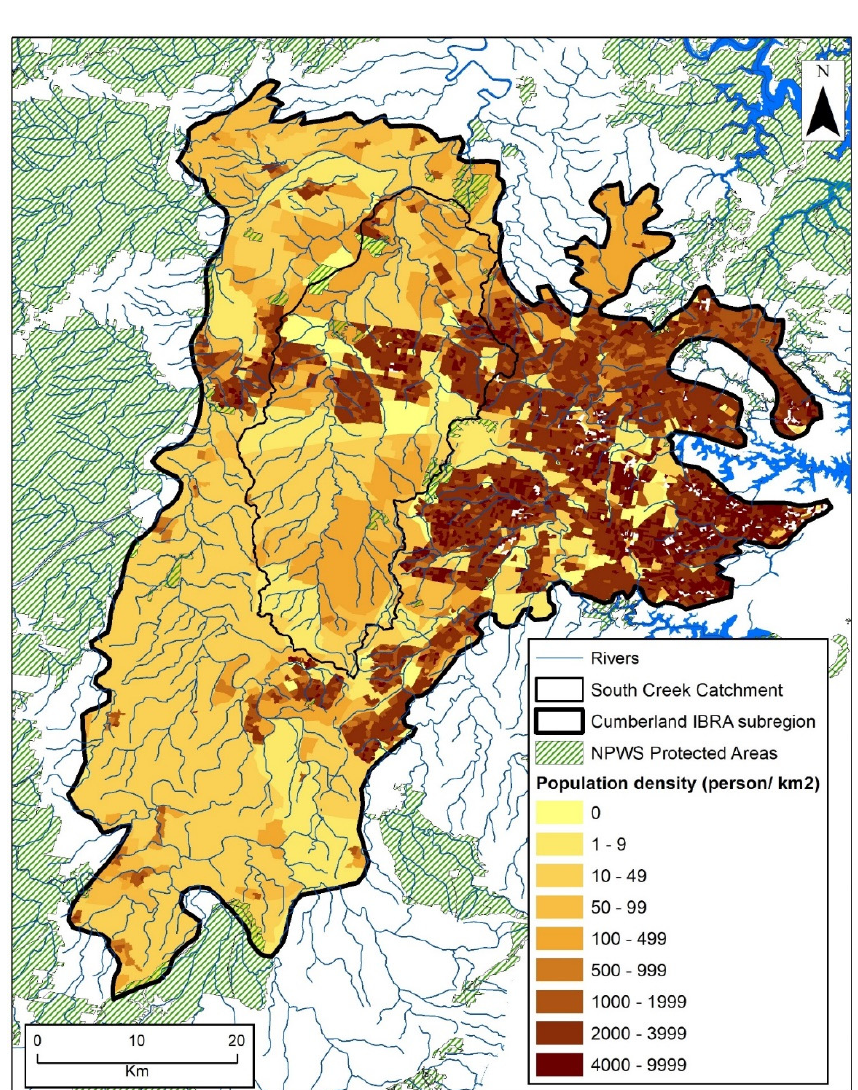
Figure 1. Population density within the study area in Western Sydney. These data come from the 2011 census and was provided by the Australian Bureau of Statistics. The data covers the same extent as the habitat suitability modelling (Cumberland IBRA subregion). The areas of primary interest in relation to urban development is the South Creek Catchment. The protected areas managed by New South Wales National Parks and Wildlife Service (NSW NPWS) in an around the bioregion are also shown.